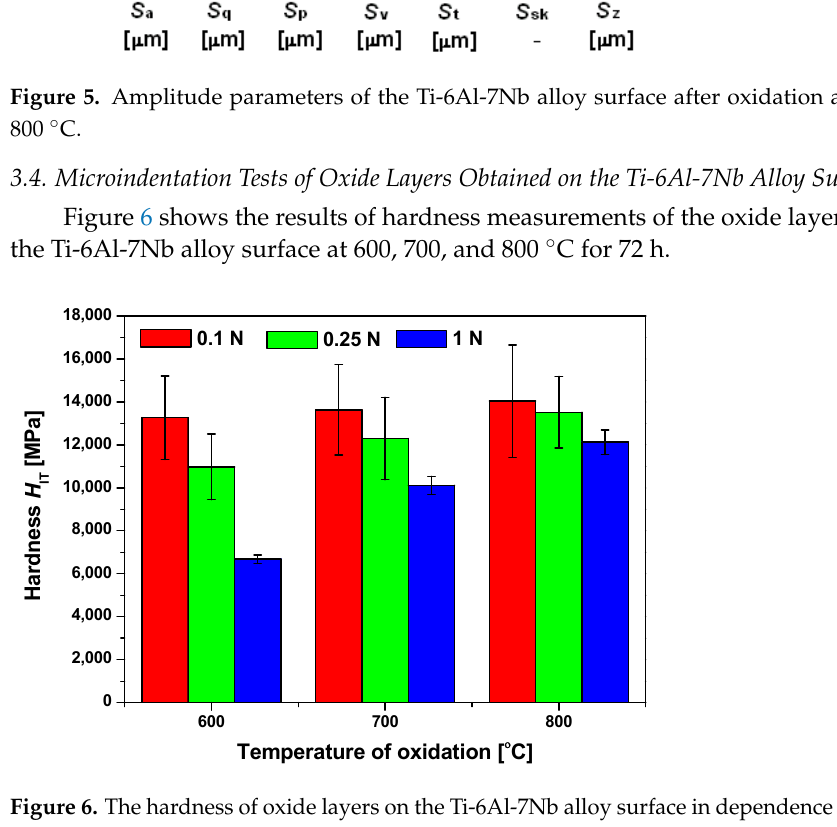
Figure 6. The hardness of oxide layers on the Ti-6Al-7Nb alloy surface in dependence of the oxidation temperature and the indenter load.